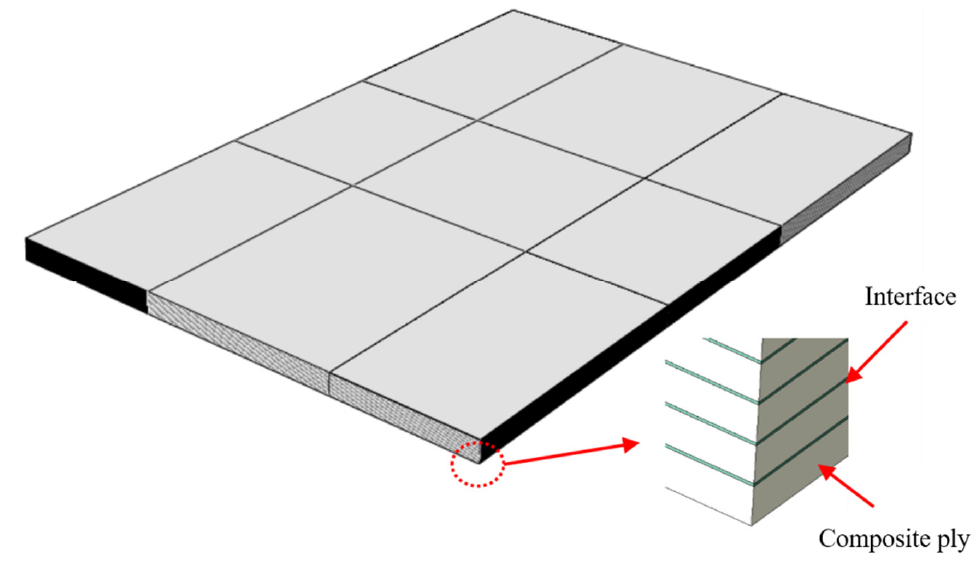
Figure 6. FEM of the composite laminate.